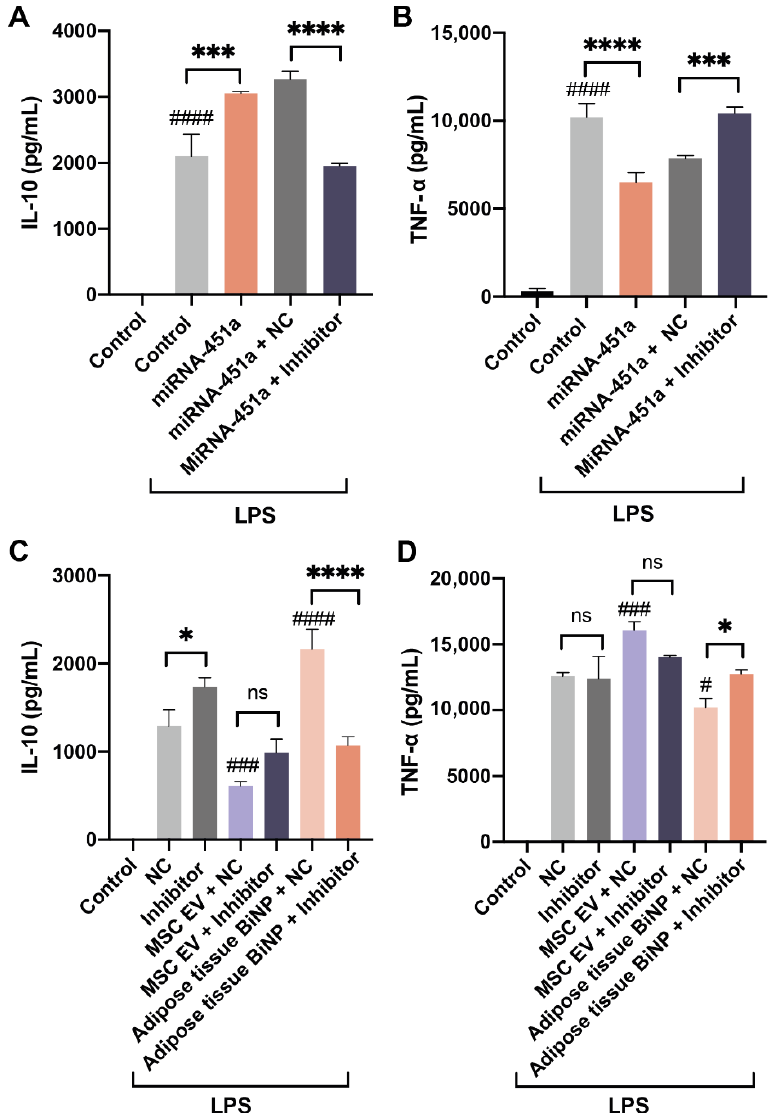
Figure 6. Effects of a miR-451a steric blocking oligonucleotide inhibitor on protein levels of IL-10 and TNF- α in RAW 264.7 macrophages exposed to LPS (500 ng/mL). Effects of co-exposure to the miR-451a inhibitor and a miR-451a synthetic mimic on IL-10 ( A ) and TNF- α ( B ) expression. Effects of co-exposure to the miR-451a inhibitor and donor-matched MSC EVs or adipose tissue BiNPs (10 9 /mL) on IL-10 ( C ) and TNF- α ( D ) expression. Data are presented as mean ± SD of three replicates. Statistics by ANOVA with Tukey’s multiple comparison post-hoc analysis. # , p < 0.05; ### , p < 0.001; #### , 0.0001 in comparison to control without LPS ( A , B ) or NC ( C , D ). *, p < 0.05; ***, p < 0.001, ****, p < 0.0001.